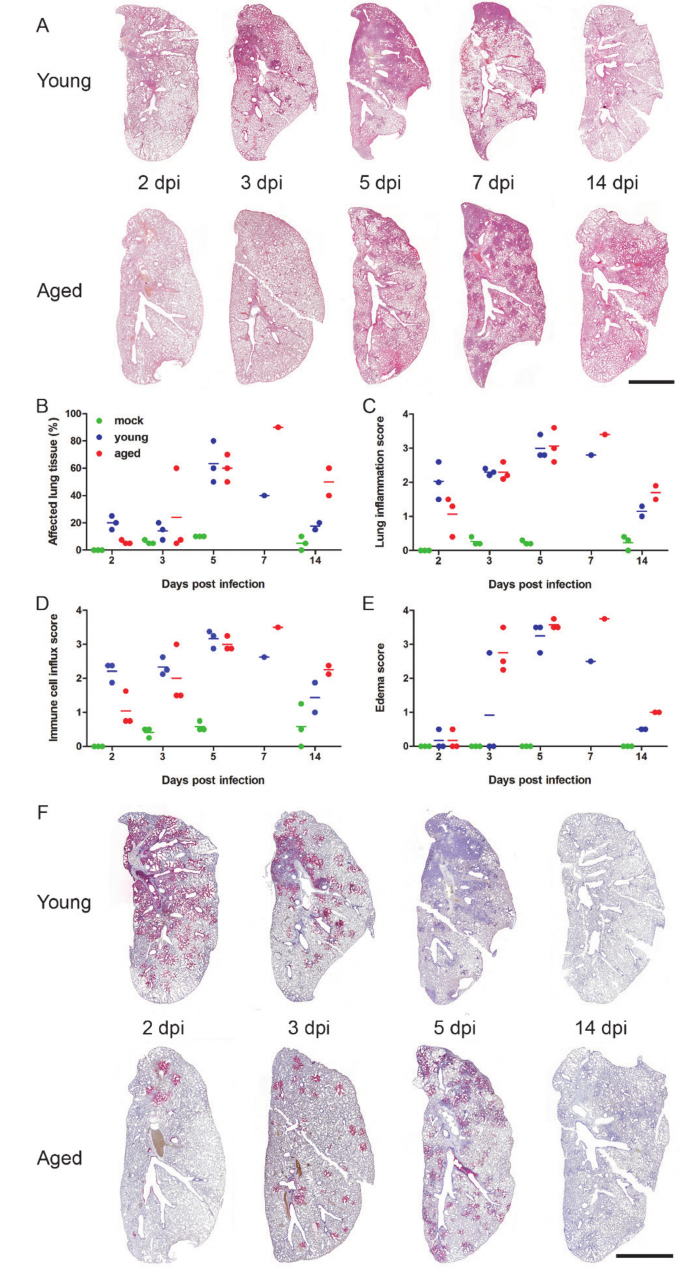
Figure 2. Lung histopathology ( A–E ) and detection of SARS-CoV-2 RNA ( F ) at di ff erent time